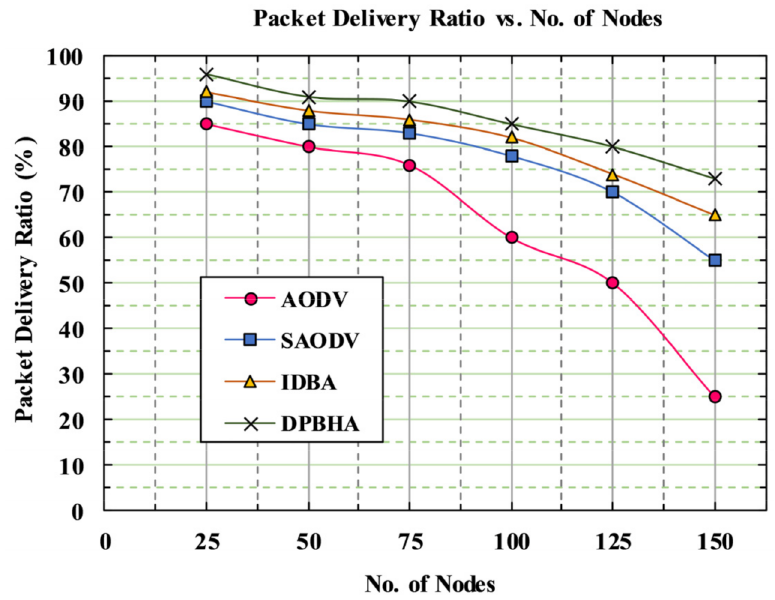
Figure 11. Graphical representation of packet delivery